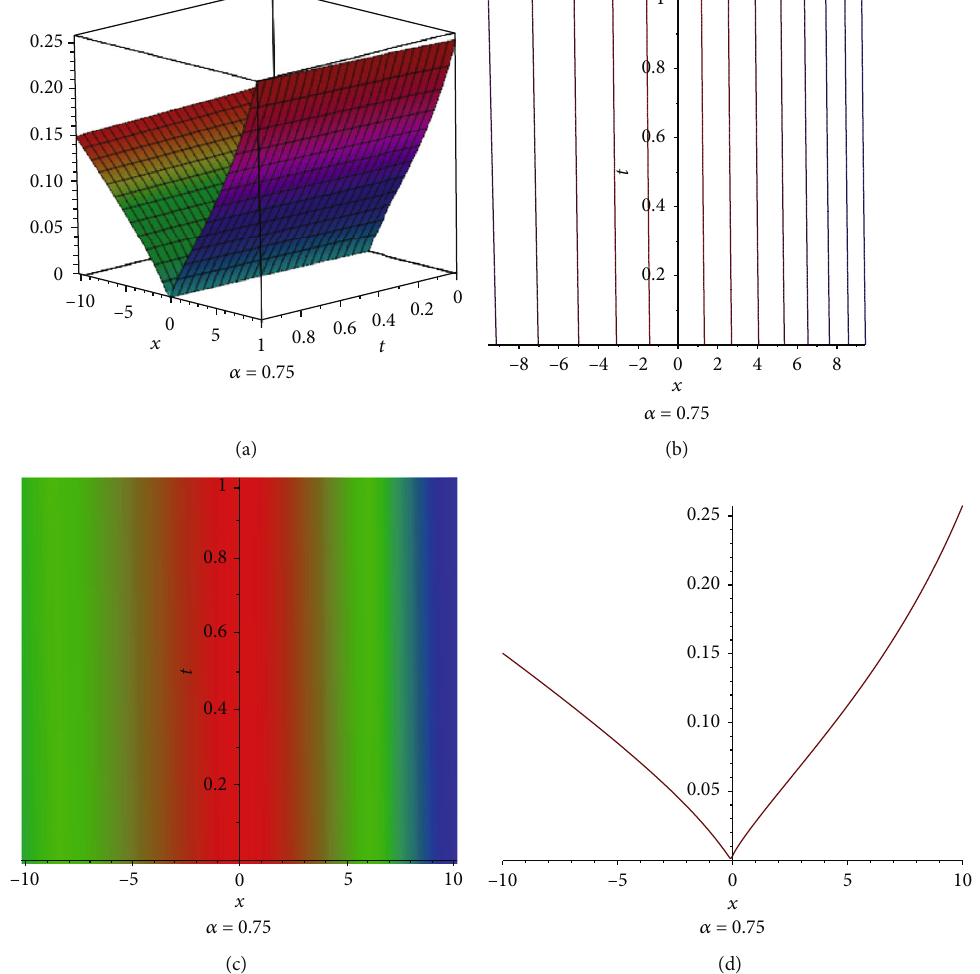
= 0 : 63, δ = δ = w = w = 1 2 3 1 2